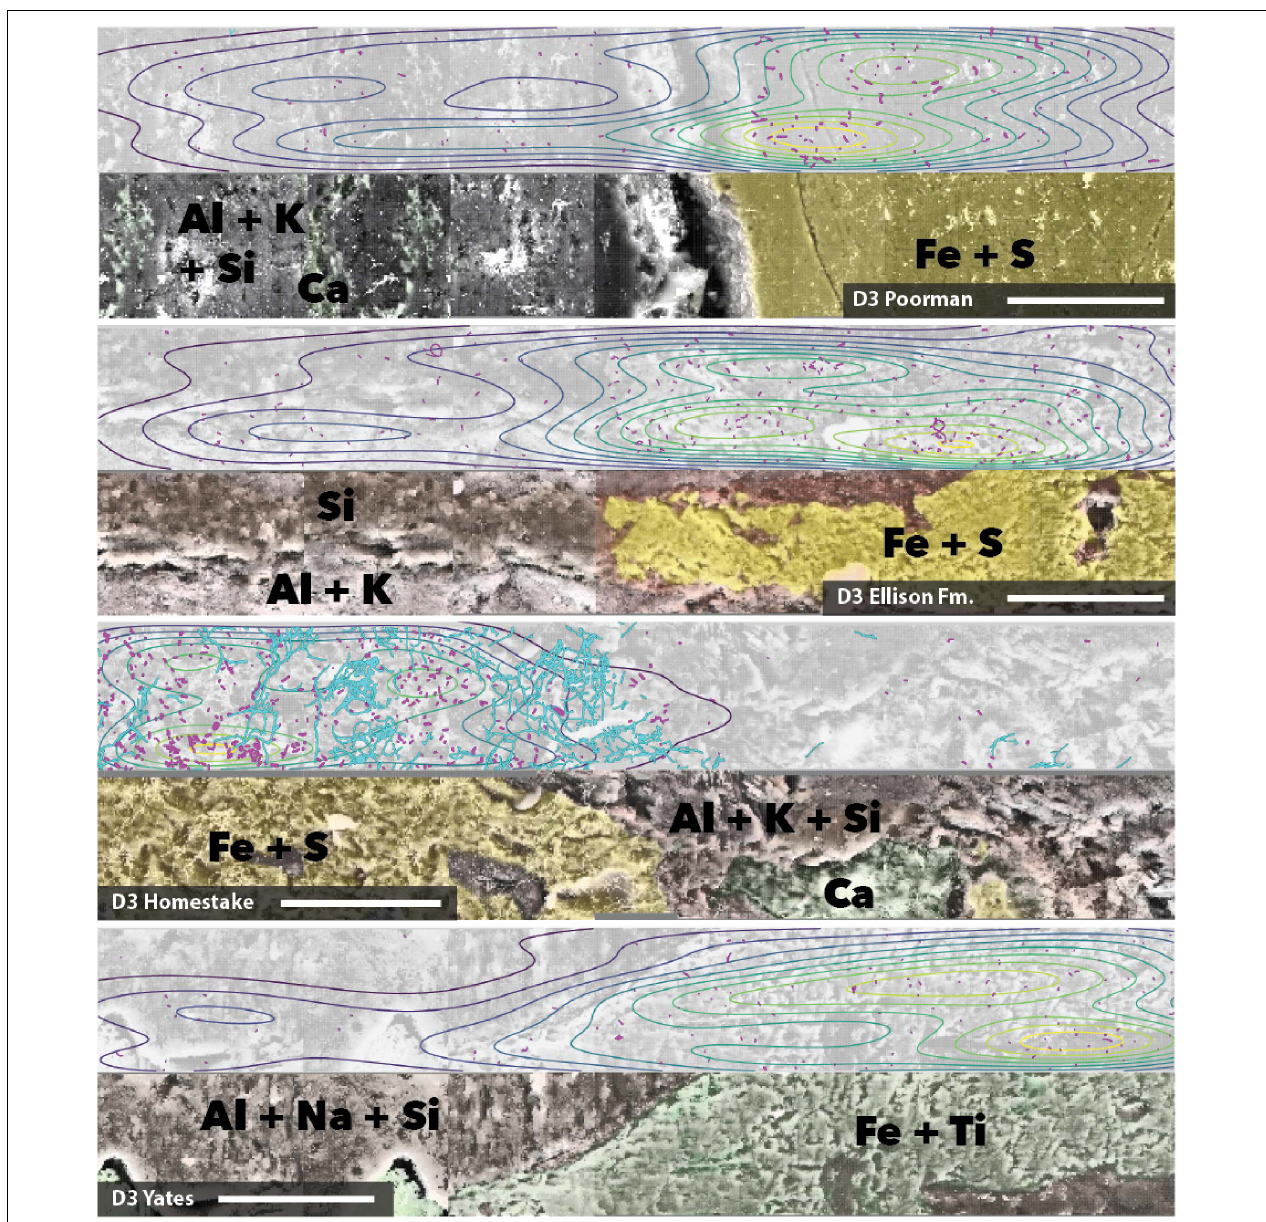
FIGURE 7 | Coupled SEM/XEDS images of DeMMO3 biofilms on native rock coupons from selected experiments. Top panels for each rock type show cell (magenta) and fungal feature (cyan) distribution with kernel density contours where yellow represents the highest density, bottom panels show coupons colored by elements. Transects are stitched images collected at 3000x magnification. Scale bars represent 50 µ